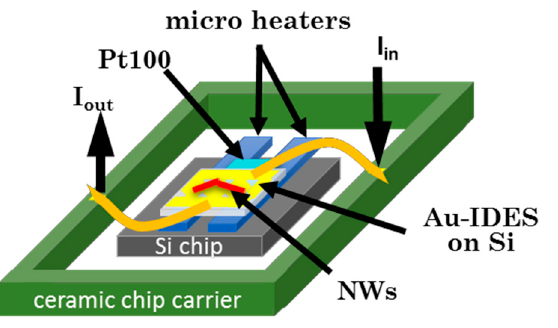
Figure 1. Scheme of Si-based gas sensing device with Au-IDES structures and external heating.